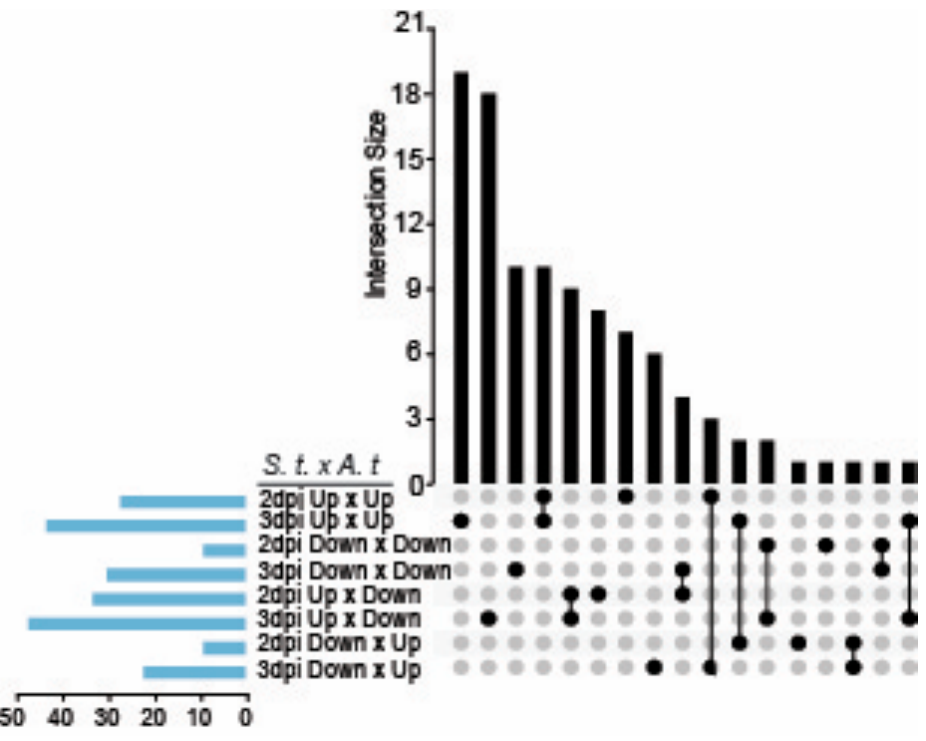
Figure 7. Functional characterization of UPR related genes in S. tuberosum DEGs. The UpSet plot shows potato DEGs (2 dpi and 3 dpi) that were also represented in a published Arabidopsis UPR DEGs dataset obtained following induction by tunicamycin (5 µg/mL) [58]. S.t. x A.t is shorthand for S. tuberosum by Arabidopsis comparison indicating DEGs that are upregulated or downregulated in both datasets or alternatively up and down regulated in each dataset.